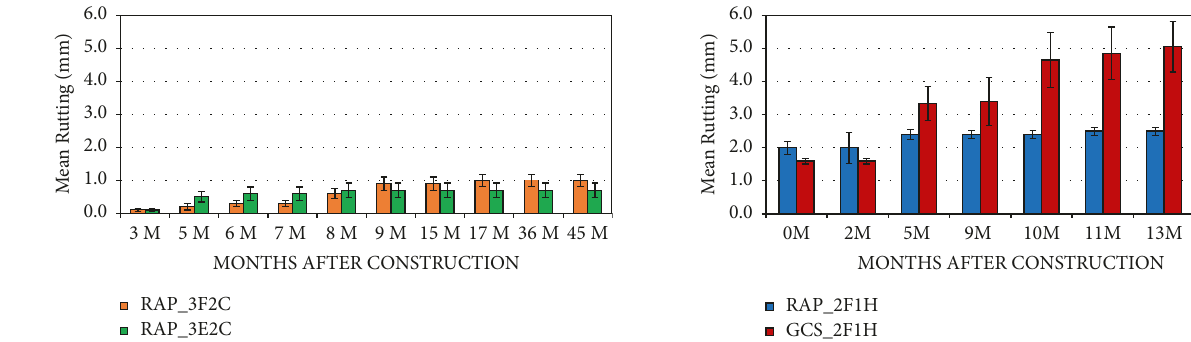
Figure 10: Mean rutting (and standard error) vs. months after construction (RAP_2F1H and